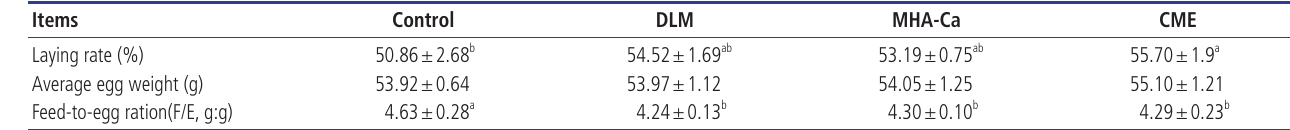
Table 2. Effects of different methionine sources on production performance of broiler breeders